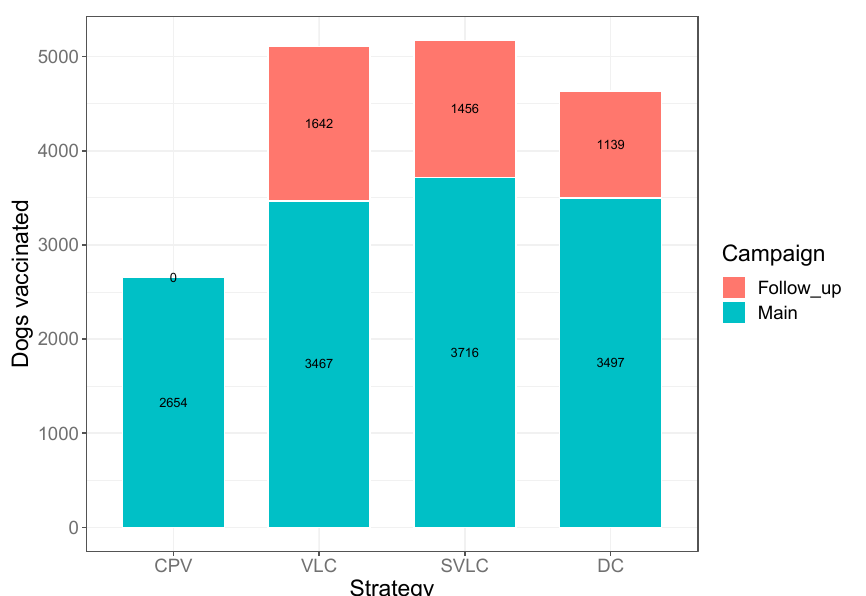
Figure 2. Dogs vaccinated in each strategy in the main and follow-up campaigns. CPV = centralized pulsed vaccination, VLC = village-level continuous decentralized vaccination, SVLC = sub-village level continuous decentralized vaccination, DC = discretionary continuous decentralized vaccination.